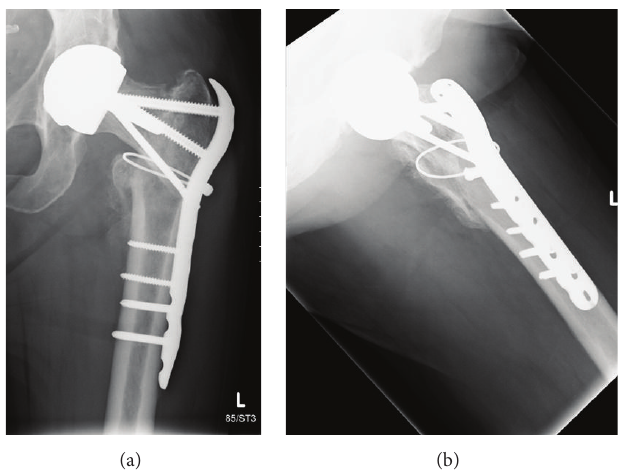
Figure 7: Showing an AP and a lateral view 4 months from